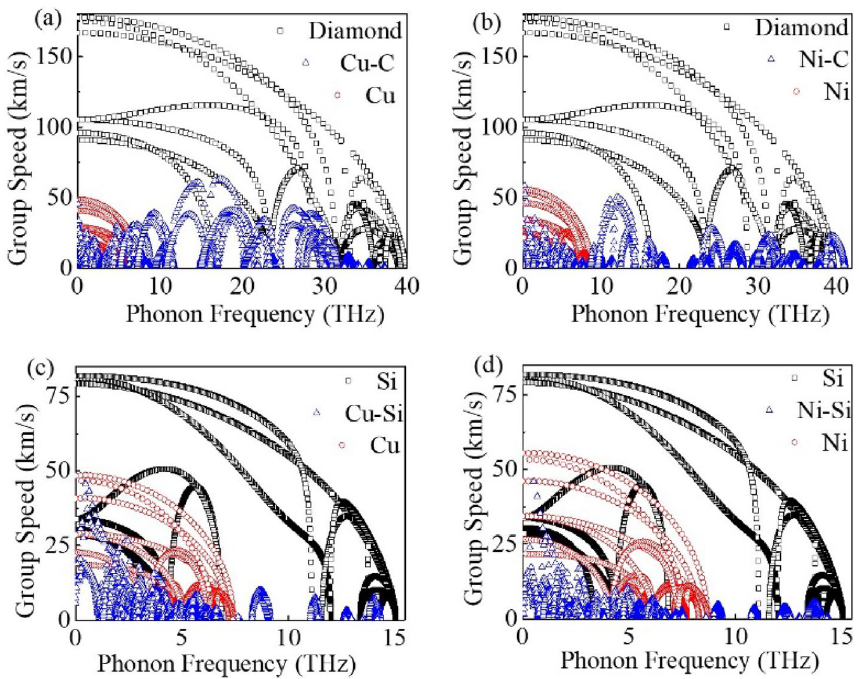
Figure 5. Phonon group velocities with respect to phonon frequency for ( a ) the Cu–C, ( b ) the Ni–C, ( c ) the Cu–Si, ( d ) the Ni–Si interfaces. Phonon group velocities for the bulk Cu, the bulk Ni, the bulk diamond and the bulk Si are also shown.